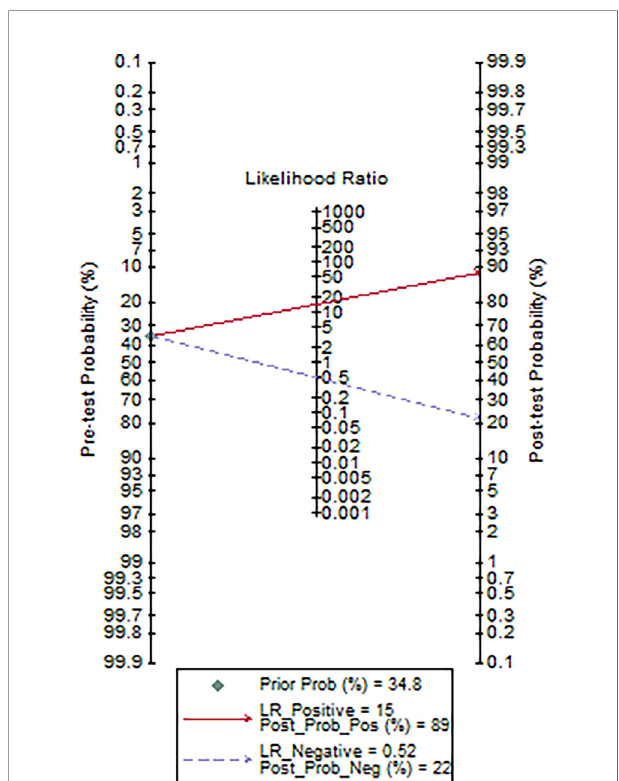
FIGURE 5 | Fagan plot of IL-6 for the hospital stay prediction of critically ill COVID-19 patients (data were available for 46